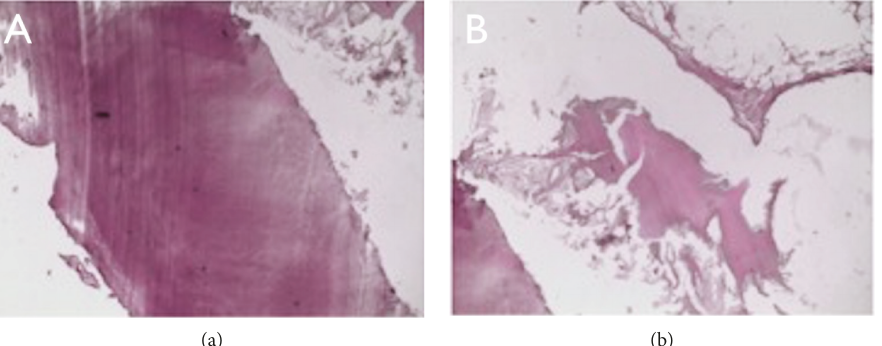
Figure 3: Histologic examination. (a) Cementum-like mineralized tissue (HE – 100x). (b) Numerous and voluminous cementoblastomas (HE – 400x).